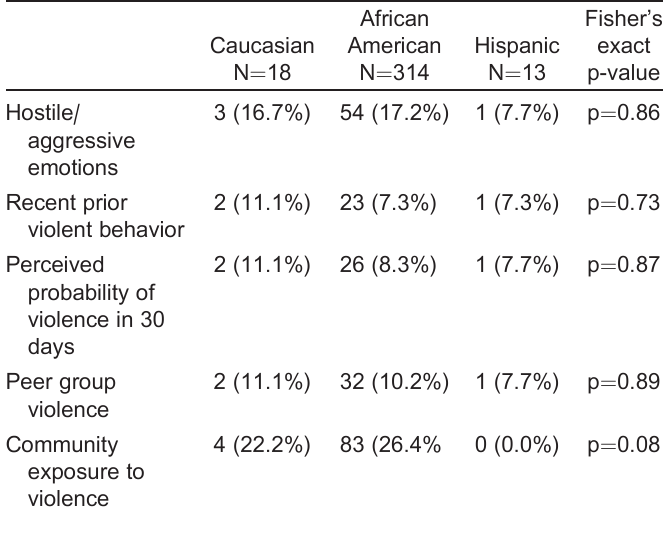
Table 2. Rates of high exposure to specific violence risk factors as associated with patient